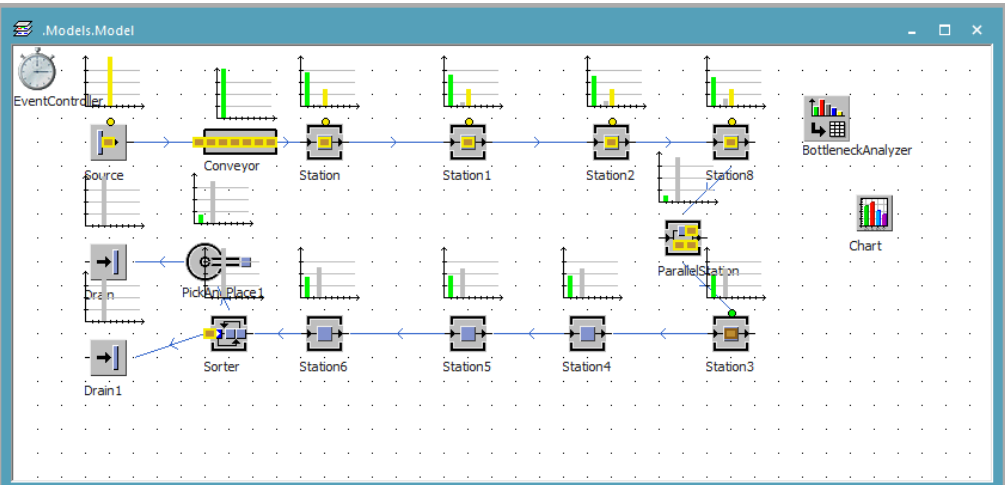
Figure 6. Identification of production bottlenecks .